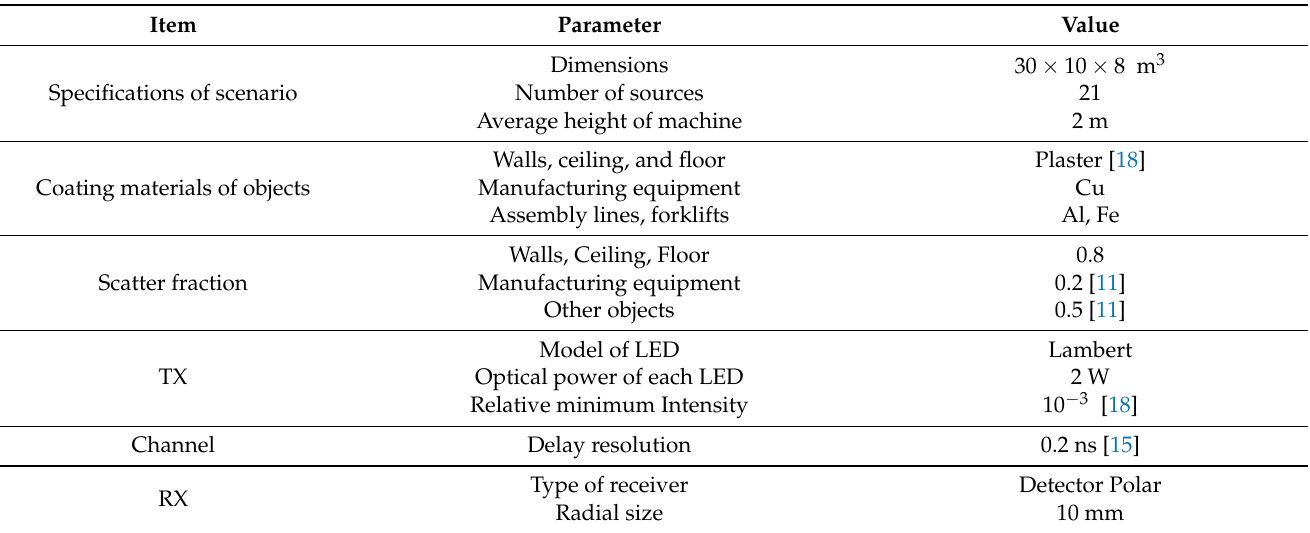
Table 1. Parameters of simulation